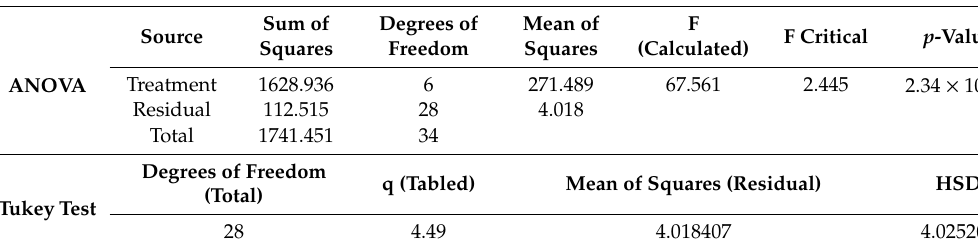
Table 4. ANOVA and Tukey results of tensile strength of neat polyester and ra ffi a composites.